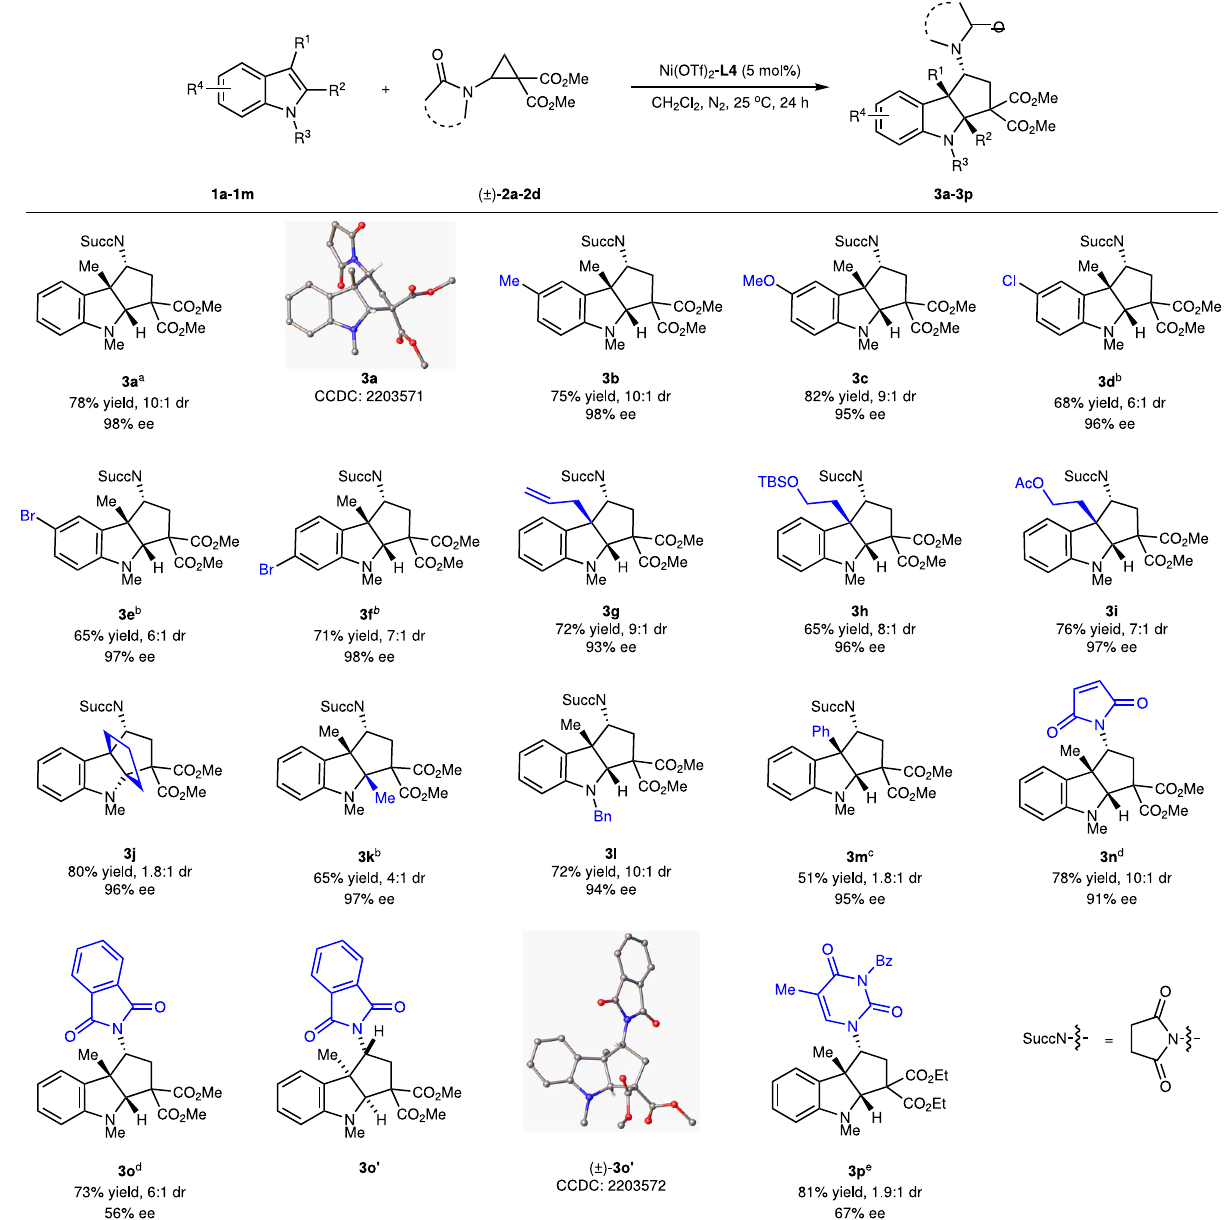
Fig. 3 | Substrate scope of the reaction. Unless otherwise noted, reaction condi- tions are as follows: Ni(OTf) 2 / L4 (1:1.2, 5mol%), 1 (0.2mmol), 2 (0.44mmol) in CH 2 Cl 2 (4.0mL) at25°C underN 2 for 24h. Isolated totalyields forproduct 3 (both diastereoisomers) were reported. The dr value was determined by 1 H NMR spectra of the crude product. The ee value was determined by chiral HPLC